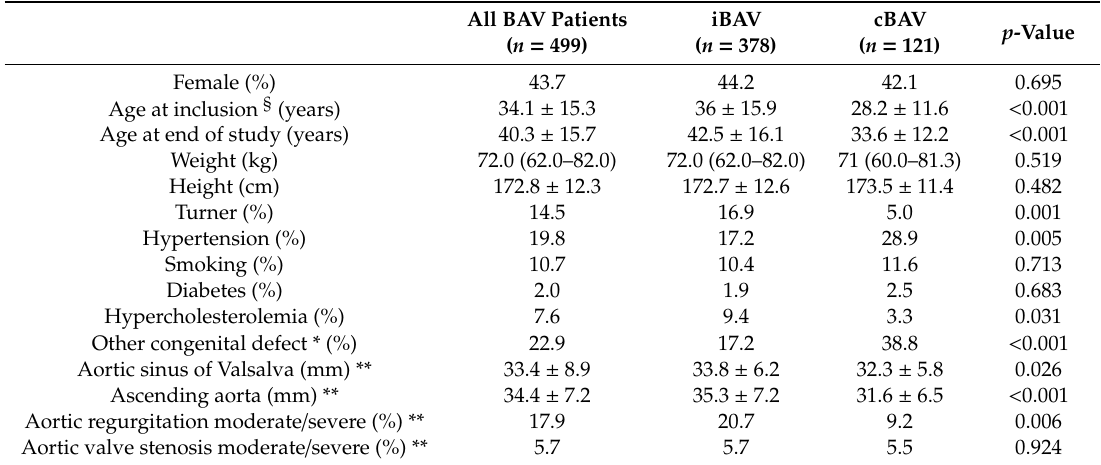
Table 1. Baseline characteristics of BAV patients with and without coarctation.